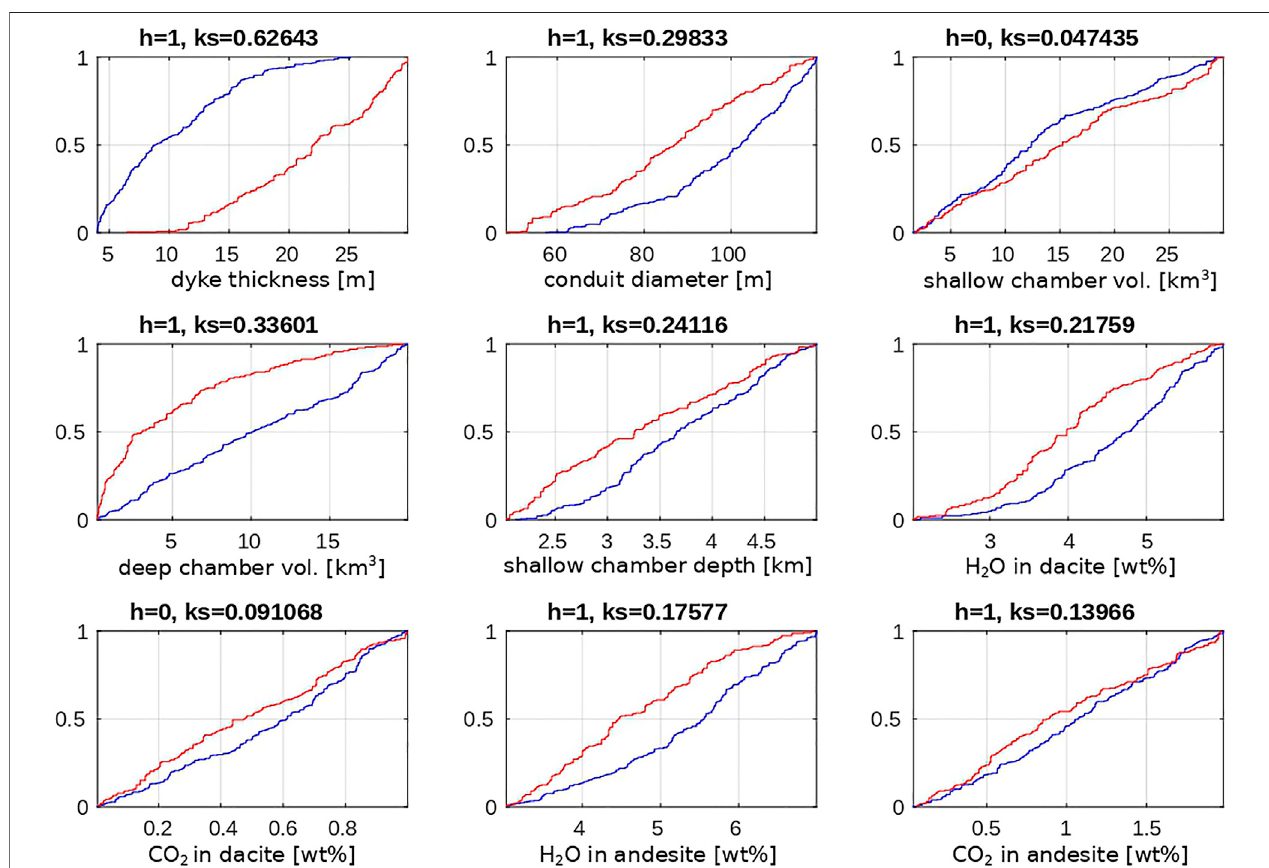
FIGURE 3 | Regional analysis results for occurrence of eruption closure by shallow (blue lines) or deep (red lines) chamber collapse. ks ( Eq. 7 ) quanti fi es the differencebetweenthetwodistributionfunctions;thelargerthevalueofks,themorein fl uentialtheinputparameter; histhehypothesistestresult( h (cid:2) 1indicatesthatthe test rejects the null hypothesis that the two distribution functions are the same at the 5% signi fi cance level).